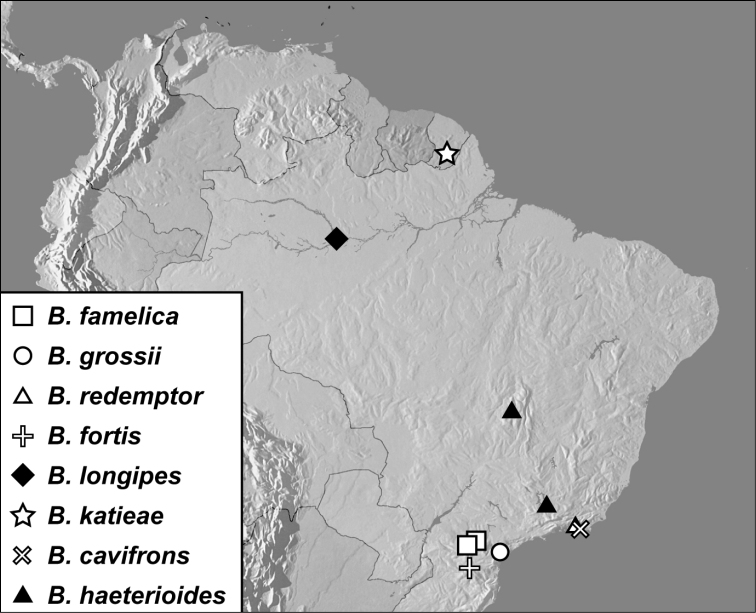
Baconia famelica group records.